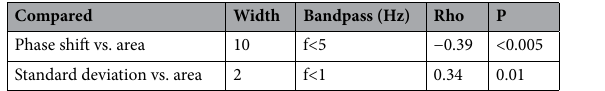
Table 1. The results of Kendall correlation analysis. Compared: Signal characteristics vs. pathology measures. Width: Width of the digital section marking. Bandpass (Hz): Frequency spectrum analysed. Rho: Correlation coefficient. P: P